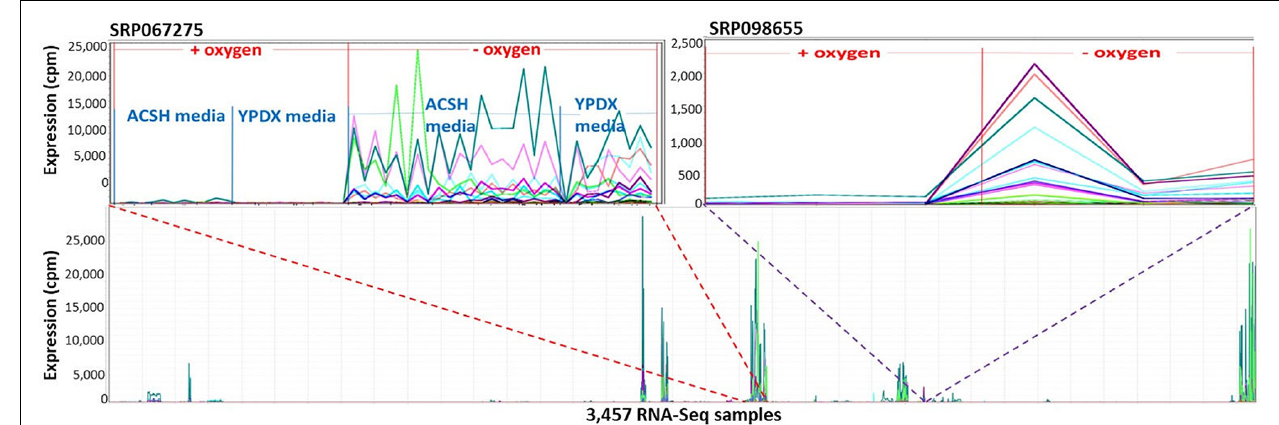
FIGURE 9 | The 41 genes and ORFs in Cluster 112 respond to anoxia. A Pearson correlation matrix of the SGD+ORF dataset was partitioned into clusters by MCL. The 41 genes and ORFs in Cluster 112 are co-expressed across multiple conditions. X -axis, 3,457-samples, sorted by study. Y -axis, expression values. Each line represents the expression pattern of a single gene or ORF. Top left inset, zoomed-in to visualize Study SRP067275. RNA-Seq samples sorted by: aerobic or anaerobic condition, media composition, and growth phase. ACSH, Ammonia Fiber Expansion-(AFEX-) pretreated corn stover hydrolysate. YPDX, YP media containing 60 and 30 g/L xylose. The genes and ORFs are up-regulated in response to anoxia, regardless of changes in growth media. Top right inset, zoom-in to visualize Study SRP098655. The genes and ORFs are up-regulated in response to anoxia, regardless of changes in growth media. No ORF in Cluster 112 is located near an annotated gene in Cluster 112. Visualizations and co-expression calculations by MOG (Singh et al.,